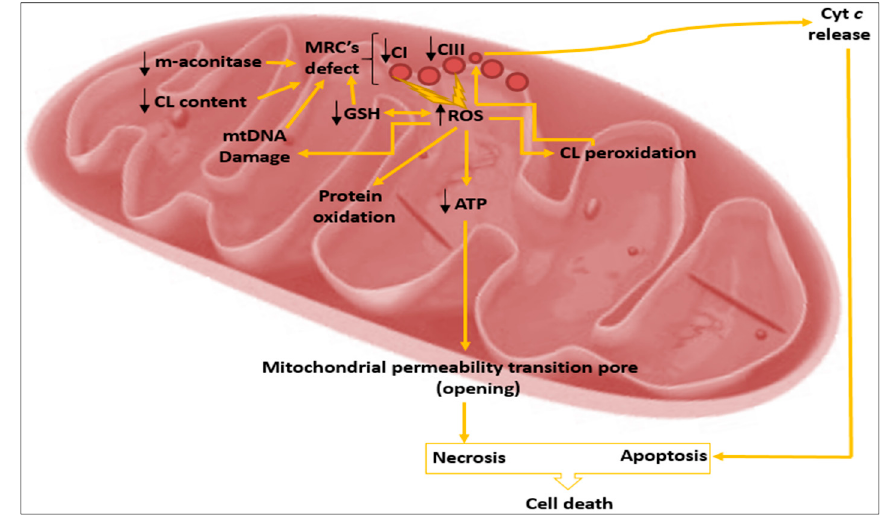
Figure 5. A summary of oxidative stress-induced mitochondrial damage is a common mechanistic link in the pathogenesis of inherited mitochondrial disorders and PD. CL: cardiolipin; mtDNA: mitochondrial DNA.